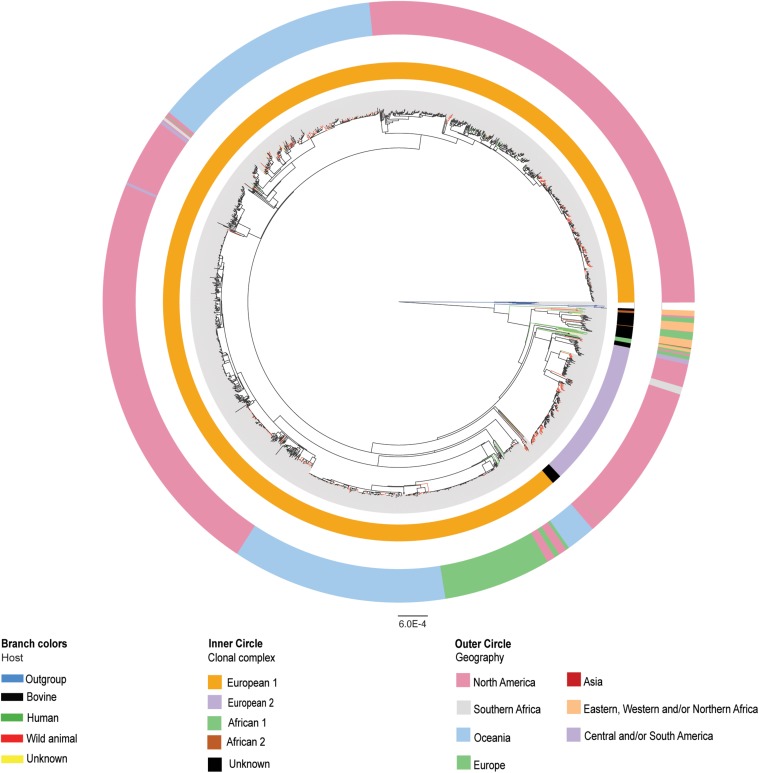
Phylogenetic reconstruction of the complete dataset of Mycobacterium bovis genomes (n = 1,969). Maximum likelihood phylogenetic tree based on single nucleotide polymorphisms (SNPs) of 1,969 Mycobacterium bovis genomes, using Mycobacterium caprae and Mycobacterium orygis as outgroup. The host species are marked in black branches for bovine, red branches for wild animals, green branches for humans, and yellow branches for unknown host identification. Outgroup members are marked in blue branches. Clonal complexes (inner circle) are marked in orange for European 1 (Eu1), purple for European 2 (Eu2), green for African 1 (Af1), brown for African 2 (Af2), and black for unknown. Geographical origin (outer circle) of M. bovis isolates are marked in pink for North America, gray for Southern Africa, blue for Oceania, purple for Central and/or South America, red for Asia, orange for Eastern, Western and/or Northern Africa, and green for Europe. Phylogenetic tree was generated using IQ-Tree with 1,000 bootstrap replicas and annotated using Iroki (Moore et al., 2019) and Adobe Illustrator. Bootstrap replicas of main nodes are all ≥90% and can be visualized in Supplementary Figure S2. Bar shows substitutions per nucleotide.